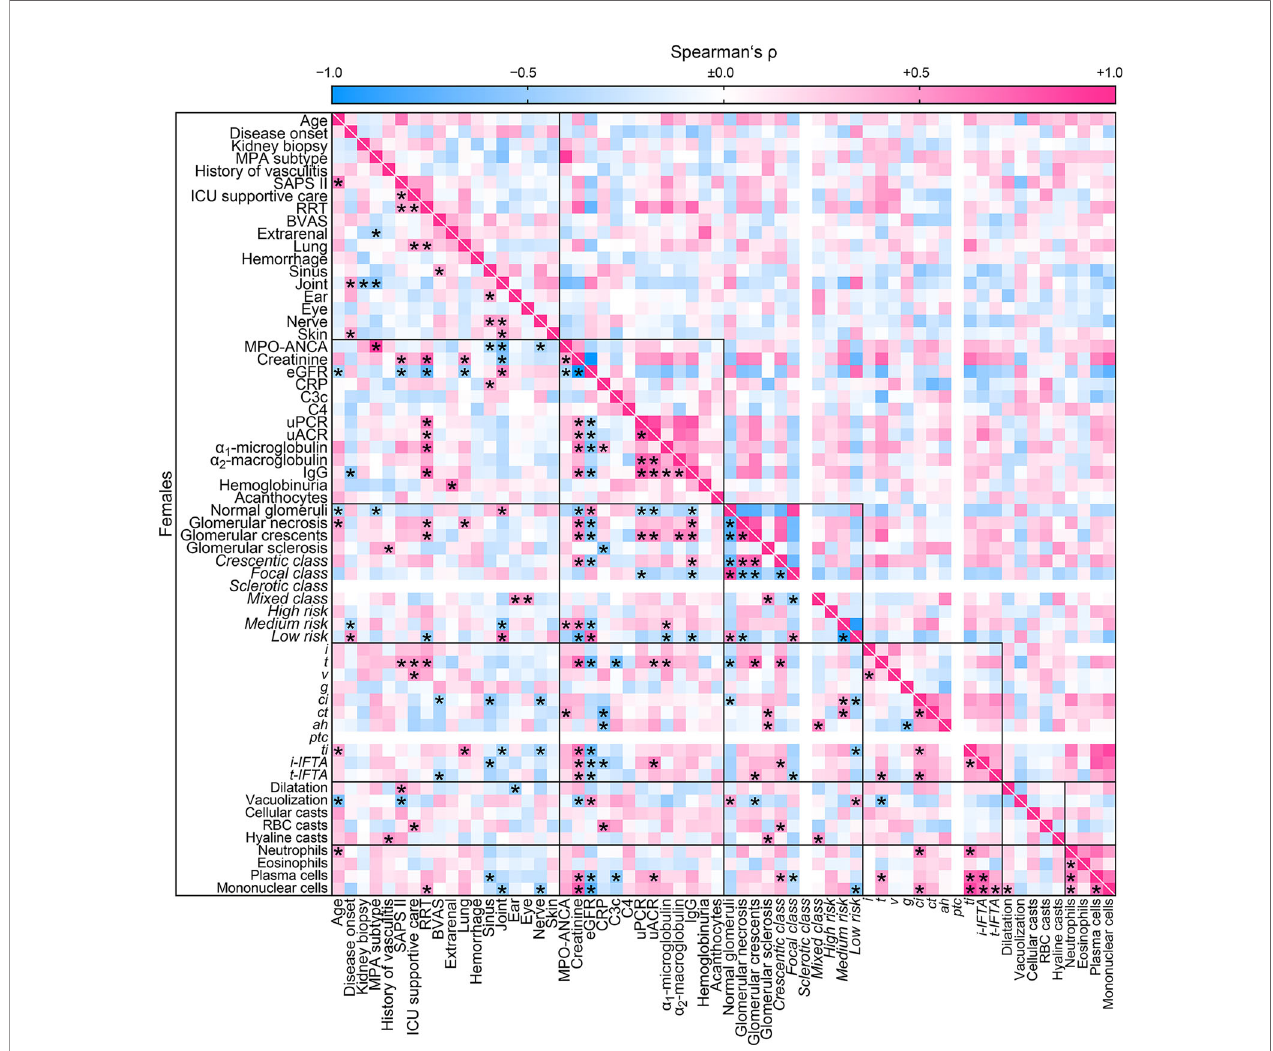
FIGURE 4 | Female-speci fi c cluster analysis for the association between clinical, laboratory parameters, and histopathological fi ndings in ANCA GN. Associations of clinical, laboratory parameters, and histopathological clusters in ANCA GN speci fi cally in females are shown by heatmap re fl ecting mean values of Spearman ’ s r , asterisks indicate p < 0.05 . Clusters are depicted by black boxes, the empty lines for sclerotic class ANCA GN and ptc within the heatmap re fl ect no data analysis because the respective parameters were absent in all cases. ah, arteriolar hyalinosis; ANCA, anti-neutrophil cytoplasmic antibodies; ATI, acute tubular injury; BVAS, Birmingham Vasculitis Activity Score; C3c, complement factor 3 conversion product; C4, complement factor 4; ci, interstitial fi brosis; CRP, C-reactive protein; ct, tubular atrophy; eGFR, estimated glomerular fi ltration rate; g, glomerulitis; GN, glomerulonephritis; i, interstitial in fl ammation; IgG, immunoglobulin G; i-IFTA, in fl ammation in IFTA; MPA, microscopic polyangiitis; MPO, myeloperoxidase; RBC, red blood cell; RRT, renal replacement therapy; t, tubulitis; ptc, peritubular capillaritis; ti, total in fl ammation; t-IFTA, tubulitis in IFTA; uACR, urinary albumin-to-creatinine ratio; uPCR, urinary protein-to-creatinine ratio; v, intimal